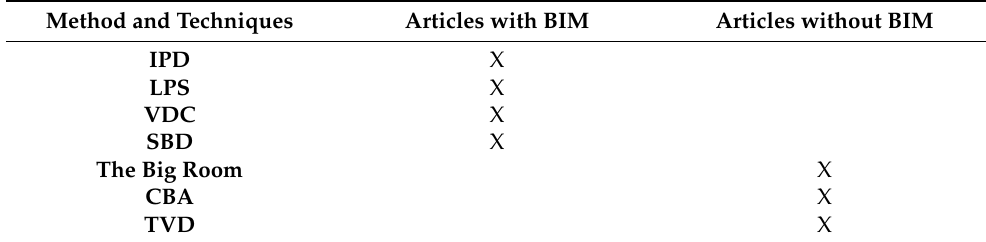
Table 5. Interaction of techniques and methods with